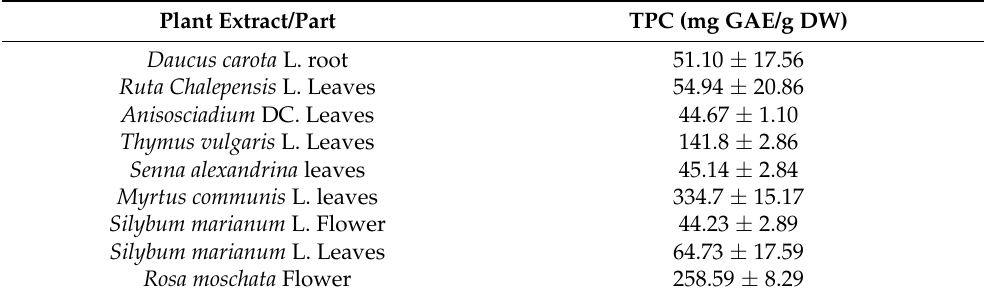
Table 1. Total polyphenols content (TPC) in the different plant extracts measured using the Folin– Ciocalteu method as a reference method. Data are expressed in gallic acid equivalent (GAE) of dry weight (DW) extract.